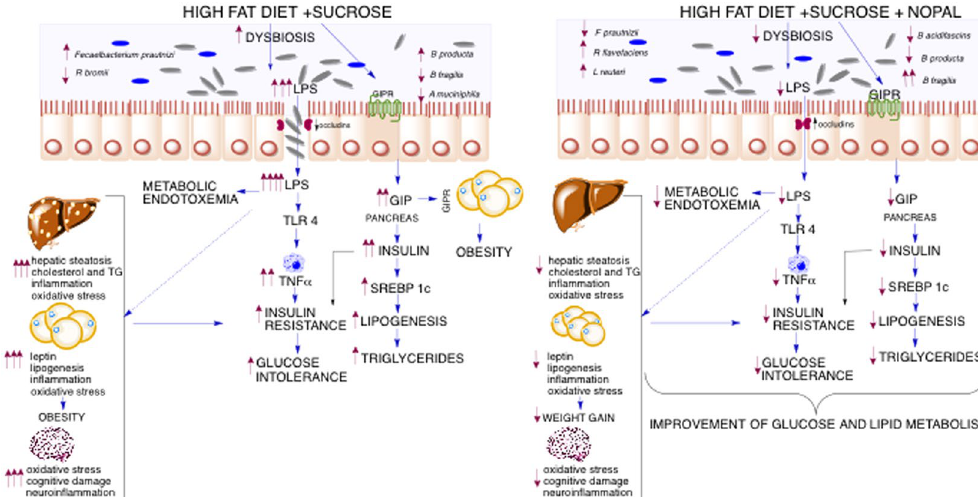
Figure 10. Consumption of nopal, a vegetable rich in soluble and insoluble fibres, polyphenols, vitamin C and with a low glycemic index, reduces gut dysbiosis and increases the abundance of occludin-1 improving intestinal permeability associated with an increase in B fragilis which in turn reduces paracellular transport of lipopolysaccharide (LPS) by the intestinal epithelium reducing metabolic endotoxemia. Nopal consumption also decreases the hypersecretion of glucose insulinotropic peptide (GIP). The metabolic consequences are a reduction in insulin resistance, lipogenesis, hepatic steatosis and cognitive damage. This figure was created using the software ChemBio Draw v. 13.0.2.3020